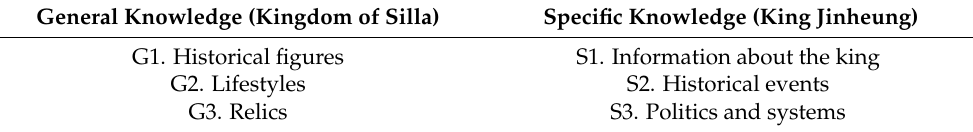
Table 1. Historical content.